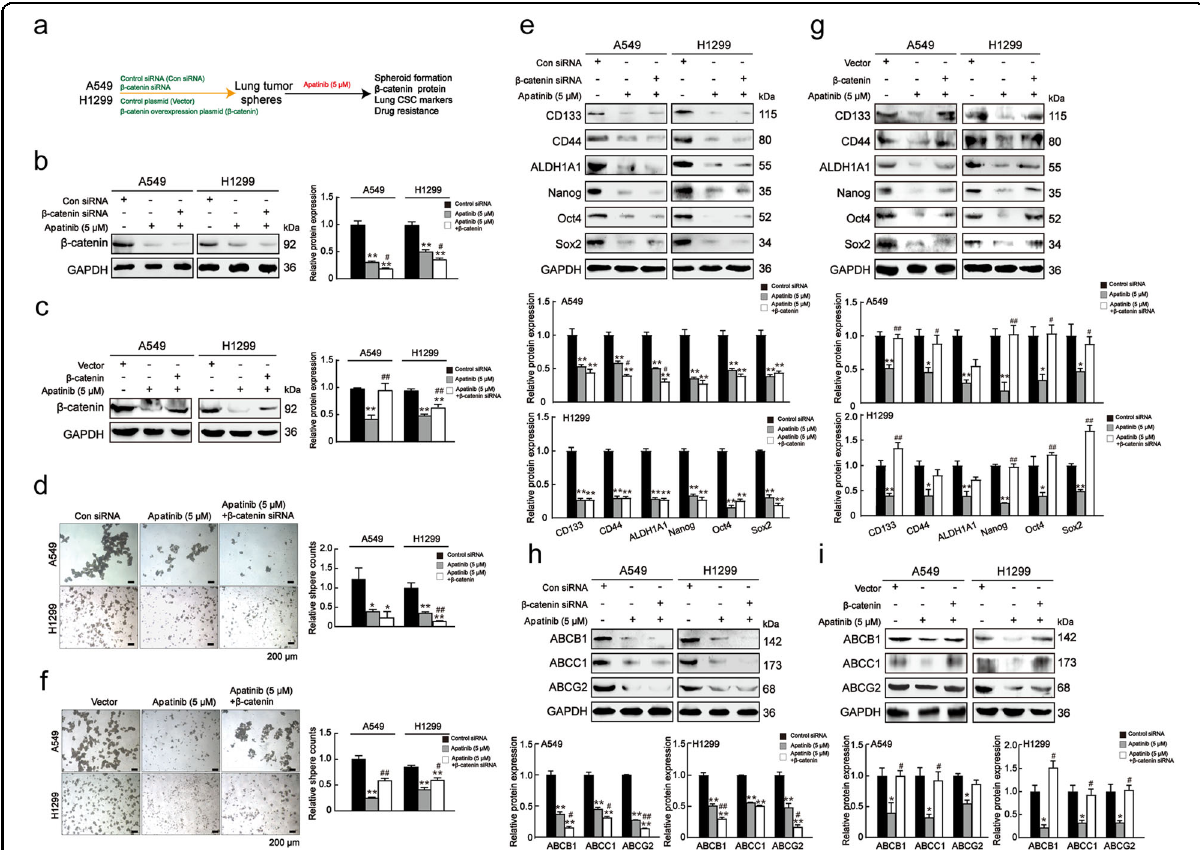
Fig. 5 Apatinib inhibited lung CSC -like properties via β -catenin. a Schematic diagram of lung tumor spheres culture after apatinib treatment with or without transfecion. A549 and H1299 cells were transfected with con siRNA, β -catenin siRNA, control vector, and pcDNA- β -catenin. After transfection, cells were treated with 5 μ M apatinib for 3 days in SFM. b – c Protein level of β -catenin in β -catenin siRNA or plasmid transfected spheroids after apatinib treatment. One-way ANOVA (Bonferroni ’ s multiple-comparison test) was used. Data are presented as mean ± SD ( n = 3). ** p < 0.01 compared to the con siRNA or vector group, # p < 0.05, ## p < 0.01 compared to the apatinib (5 μ M) group. d Sphere-forming capacities of cells transfected with con siRNA or β -catenin siRNA after apatinib treatment. Scale bar = 200 μ m. One-way ANOVA (Bonferroni ’ s multiple-comparison test) was used. Data are presented as mean ± SD ( n = 3). * p < 0.05, ** p < 0.01 compared to the con siRNA group. ## p < 0.01 compared to the apatinib (5 μ M) group. e Protein levels of lung CSC markers in β -catenin-suppressed spheroids after apatinib treatment. One-way ANOVA (Bonferroni ’ s multiple-comparison test) was used. Data are presented as mean ± SD ( n = 3). ** p < 0.01 compared to the con siRNA group, # p < 0.05 compared with the apatinib (5 μ M) group. f Sphere-forming capacities of cells transfected with control vector or pcDNA- β -catenin after apatinib treatment. Scale bar = 200 μ m. One-way ANOVA (Bonferroni ’ s multiple-comparison test) was used. Data are presented as mean ± SD ( n = 3). * p < 0.05, ** p < 0.01 compared to the vector group, ## p < 0.01 compared to the apatinib (5 μ M) group. g Protein levels of lung CSC markers in β -catenin-overexpressed spheroids after apatinib treatment. One-way ANOVA (Bonferroni ’ s multiple-comparison test) was used. Data are presented as mean ± SD ( n = 3). * p < 0.05, ** p < 0.01 compared with the vector group, # p < 0.05, ## p < 0.01 compared with the apatinib (5 μ M) group. h – i Protein levels of drug resistance- related genes in β -catenin- overexpressed or suppressed lung cancer spheroids after apatinib treatment. One-way ANOVA (Bonferroni ’ s multiple- comparison test) was used. Data are presented as mean ± SD ( n = 3). * p < 0.05, ** p < 0.01 compared to the con siRNA or vector group, # p < 0.05, ## p < 0.01 compared to the apatinib (5 μ M)